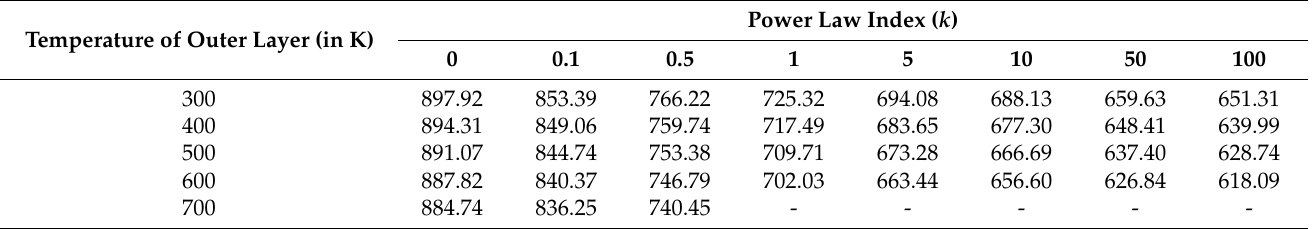
Table 11. Critical buckling temperature (in K) of a Ti-6Al-4V/silicon carbide FGM shell under linear temperature rise for different material composition in re-entry vehicle nose structures.